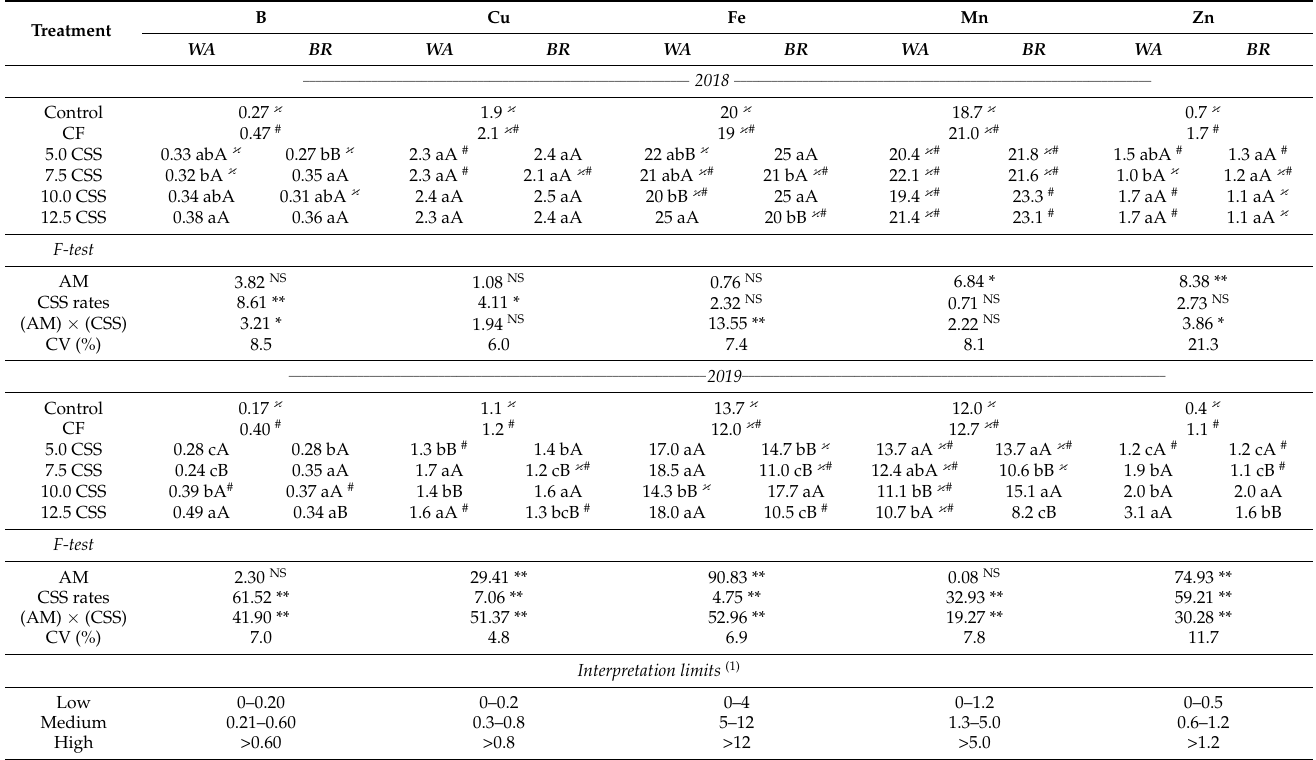
Table 1. Boron, Cu, Fe, Mn, and Zn concentration (mg dm − 3 ) in soils at the end of the investigated crop